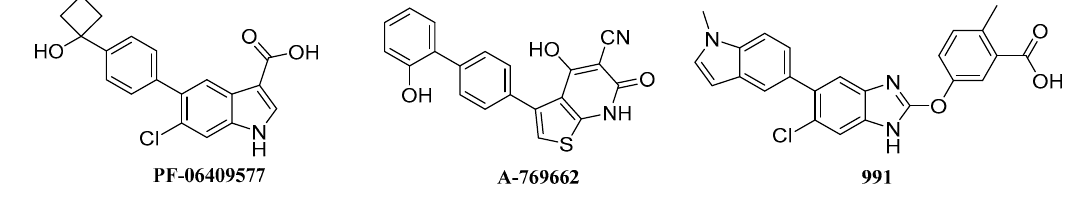
Figure 1. Structures of reported direct AMPK activators.